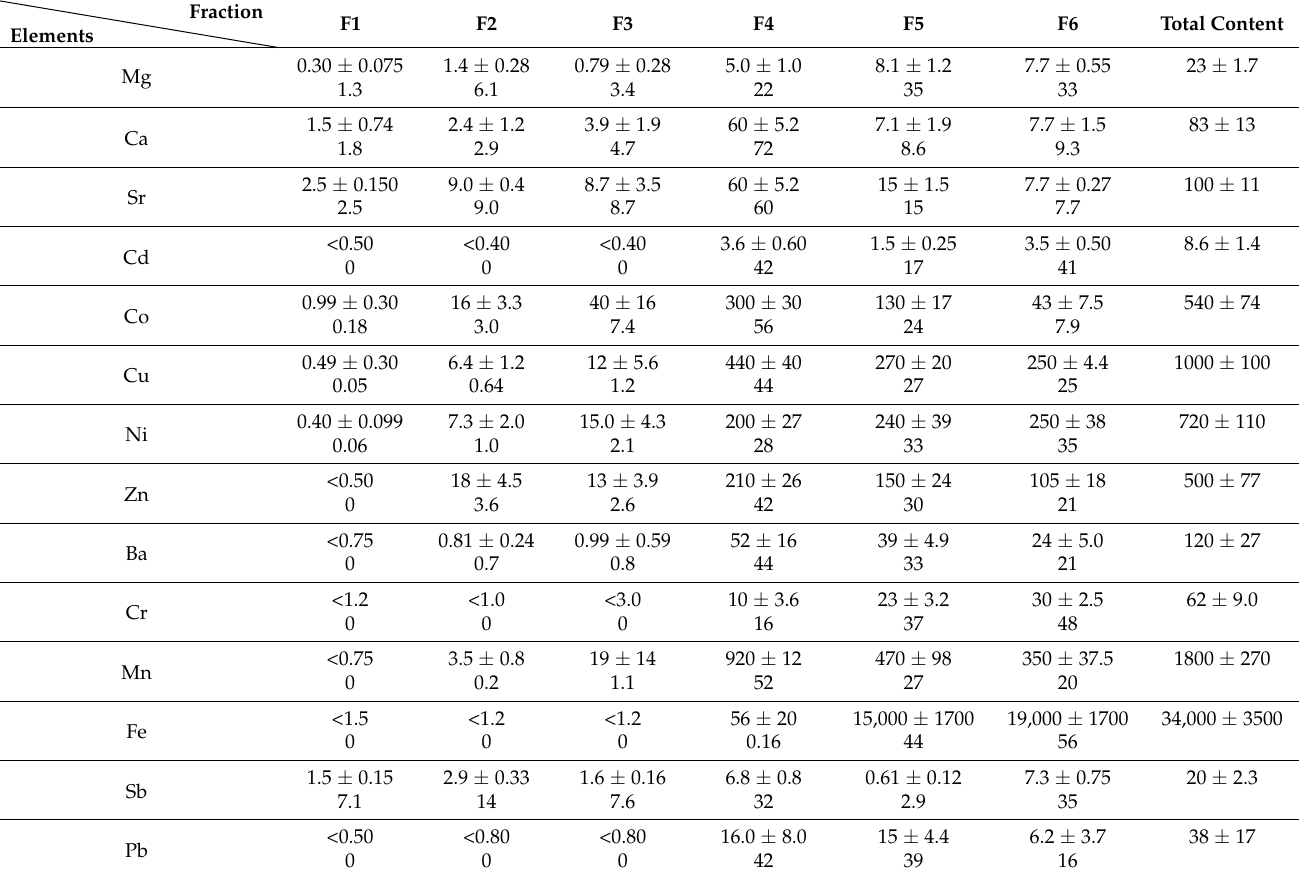
Table 8. Distribution of elements in the solid tailings by mobility fractions (in numerator): Mg and Ca in g/kg, Sr–Pb in mg/kg, and percentage of each fraction (in denominator),